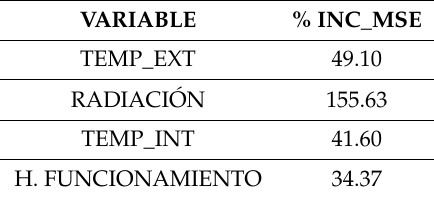
Table 6. Importance of the variables.